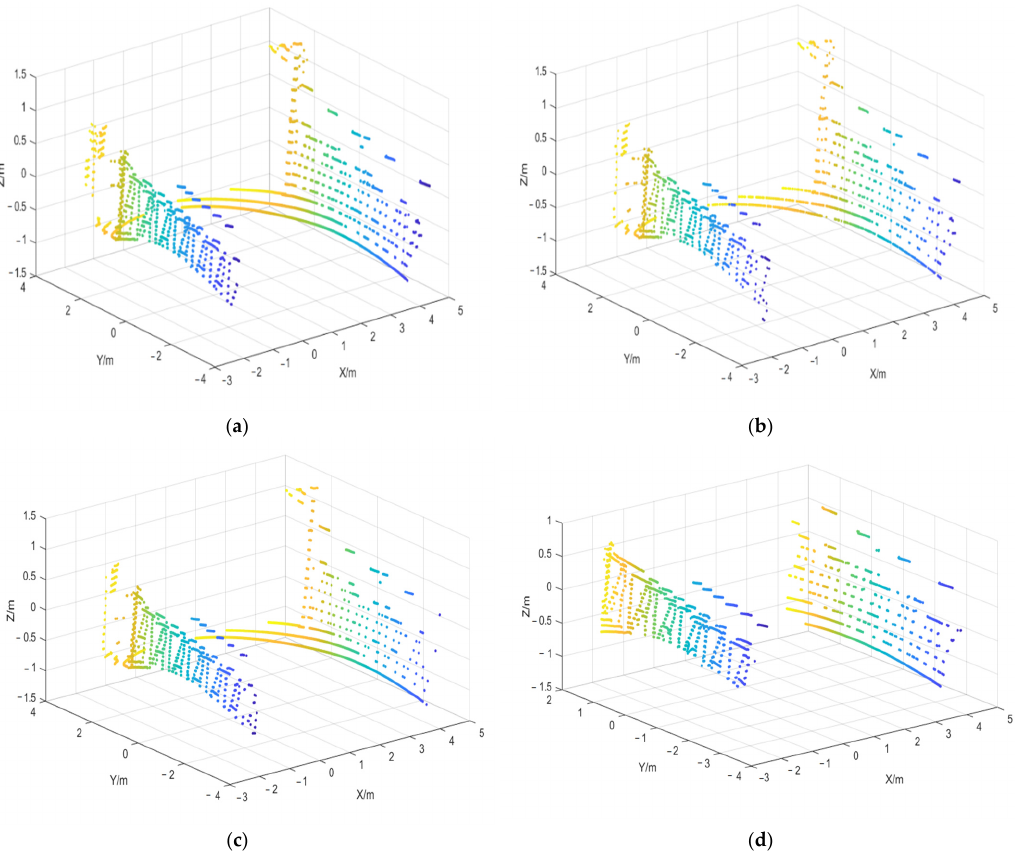
Figure 8. Visualization diagram of point cloud preprocessing: ( a ) Through filtered point cloud, ( b ) Statistical filtered point cloud, ( c ) Down sampling filtered point cloud, ( d ) Point cloud after ground removal.